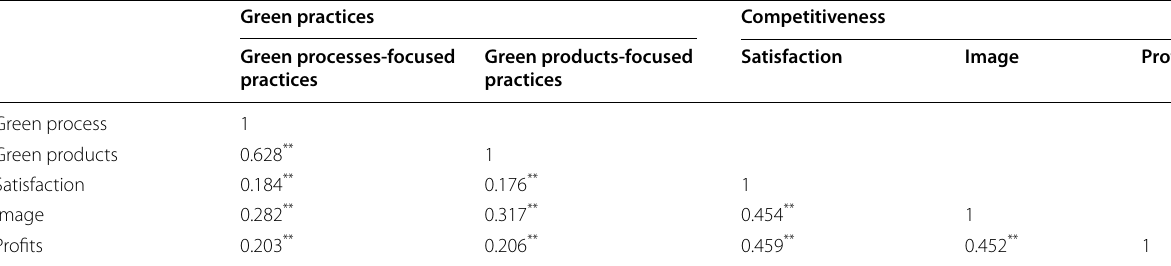
Table 4 Correlation analysis